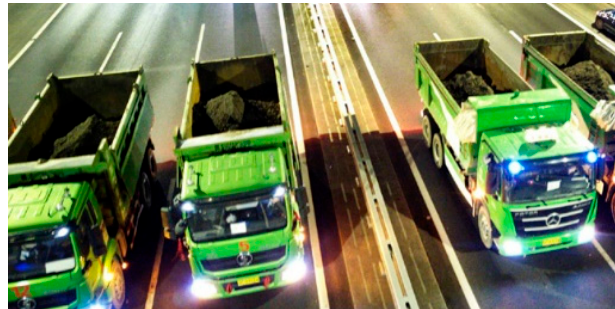
Figure 13. Loading trucks in the field experiment.